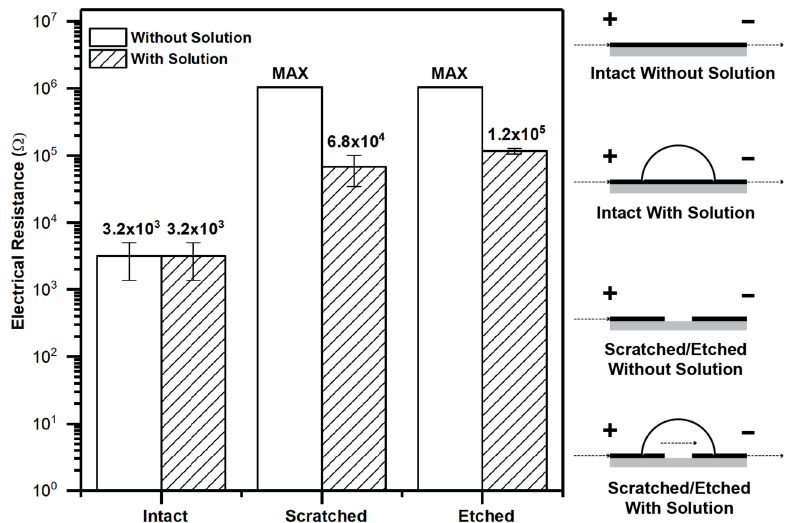
Figure 3. Plot of the measured average electrical resistance of an intact graphene film, a graphene film where electrodes were fabricated by physical scratching, and a graphene film where the electrode structure was created by plasma etching. Data are shown for both the electrode structure alone (without solution, clear bars) and for a device filled with crystallization solution (hatched bars), and are the average of measurements from three separate devices. The maximum resistance measured for the two electrode structures in air suggests an infinite resistance, beyond the range of the